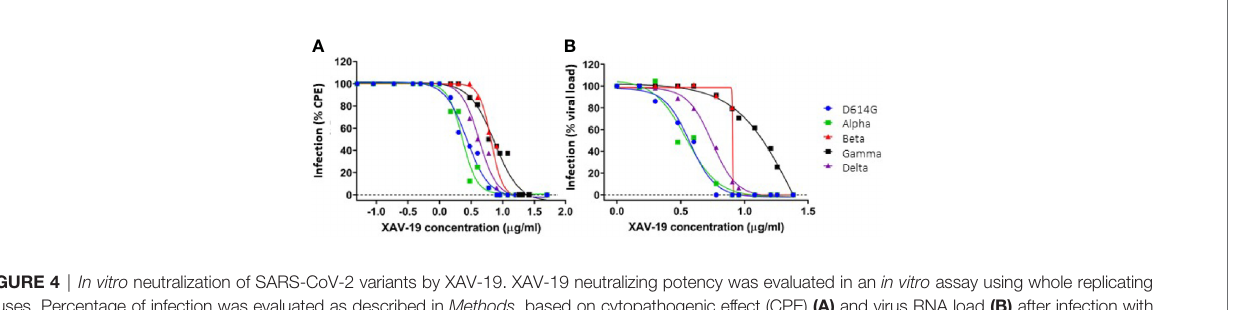
FIGURE 4 | In vitro neutralization of SARS-CoV-2 variants by XAV-19. XAV-19 neutralizing potency was evaluated in an in vitro assay using whole replicating viruses. Percentage of infection was evaluated as described in Methods , based on cytopathogenic effect (CPE) (A) and virus RNA load (B) after infection with SARS-CoV-2 viruses of the indicated variants. CPE percentage was assessed by microscopy examination and calculated on eight replicates for each XAV-19 concentration. 100% represents the absence of CPE inhibition at the studied concentration, as found in control (no inhibitor) condition. Viral load percentage was calculated as the ratio of the viral load in each XAV-19 concentration to the viral load in controls (no inhibitor). XAV-19 concentrations are expressed on a 10 logarithmic scale. Blue dot: D614G/B.1 variant; green square: Alpha/UK/B.1.1.7 variant; red triangle: Beta/SA/B.1.351 variant; black square: Gamma/BR/P.1 variant; purple triangle: Delta/B.1.617.2 variant.